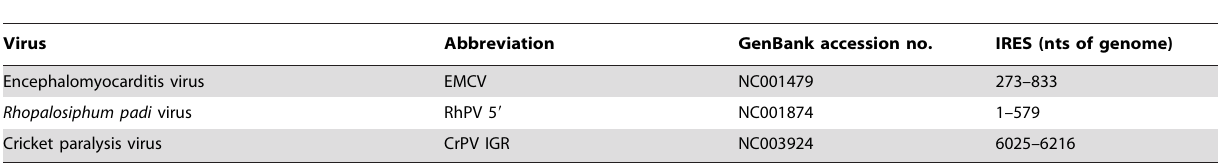
Table 1. Summary of viral IRES elements investigated in this